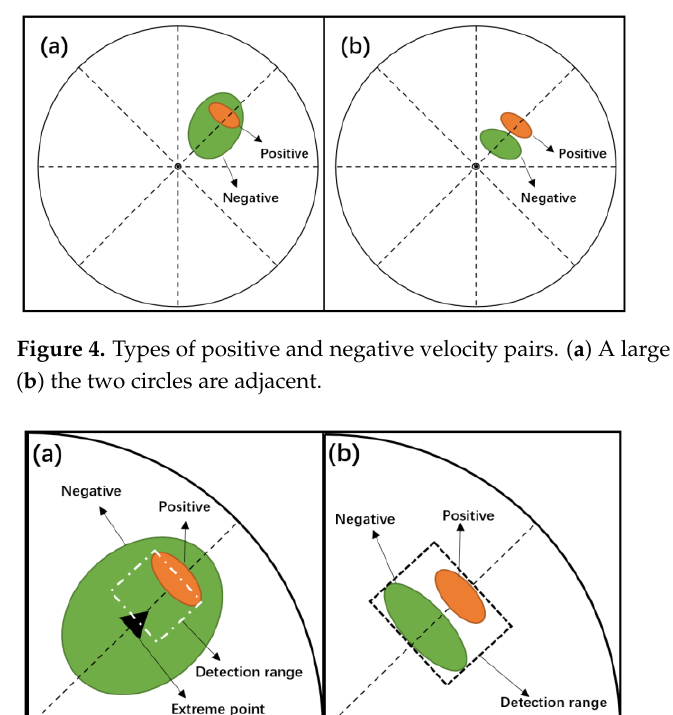
Figure 4. Types of positive and negative velocity pairs. ( a ) A large circle encloses a small circle, and ( b ) the two circles are adjacent.